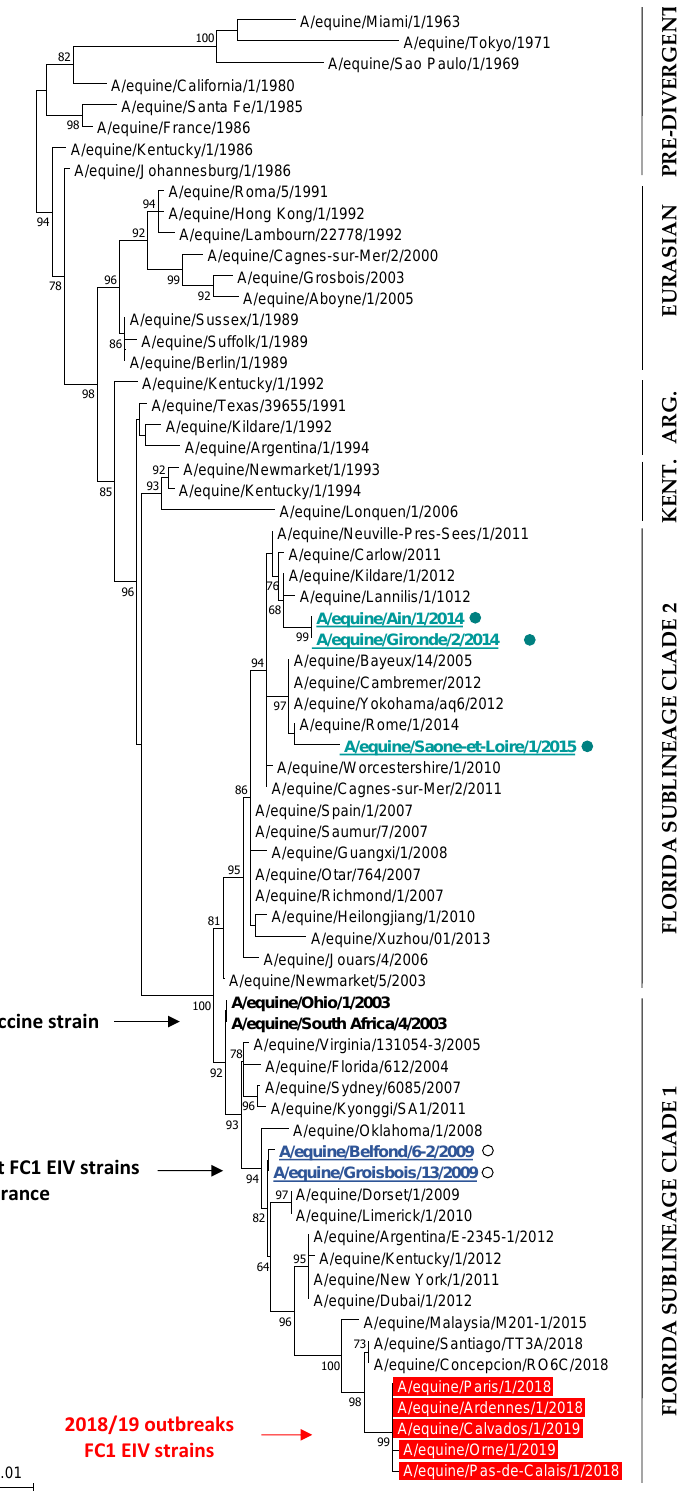
Figure 6. Phylogenetic analysis of the HA1 nucleotide sequence for 69 EIV strains, including representative strains of the main lineages and sub-lineages. The last French EIV strains belonging to the Florida sublineage clade 1 and clade 2 are underlined (open and closed circles, respectively). The FC1 EIV strains from the 2018 and 2019 French outbreaks are in red. The FC1 EIV vaccine strains are in bold text. Neighbor-Joining, Test phylogeny: Bootstrap method with 1000 bootstrap replication, Mode/method: Maximum composite Likelihood.